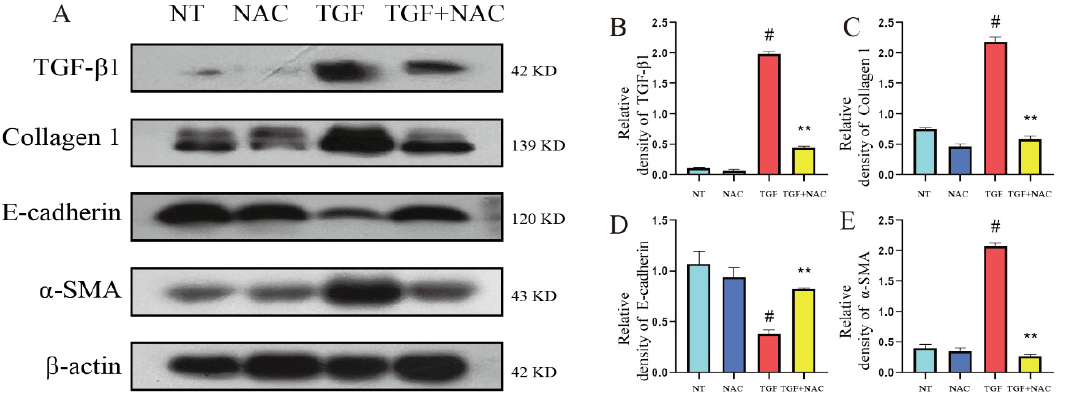
Figure 7. Effects of inhibition of ROS accumulation on TGF- β 1-induced fibrotic phenotype of bMECs. The ROS scavenging reagent NAC (3 mM) was added to DMEM, then 1 h later TGF- β 1 was added to DMEM to stimulate bMECs for 48 h. ( A ) The protein levels of TGF- β 1, collagen 1, E-cadherin, α -SMA, vimentin. ( B – E ) Quantification of TGF- β 1, collagen 1, E-cadherin, α -SMA, vimentin protein levels in bMECs. Data were analyzed by one-way ANOVA method. The data error is presented in the form of mean ± SEM. The results of the experiment are the result of three independent repeated experiments. # p < 0.01 compared with the control group, ** p < 0.01 compared with the TGF- β 1 group.